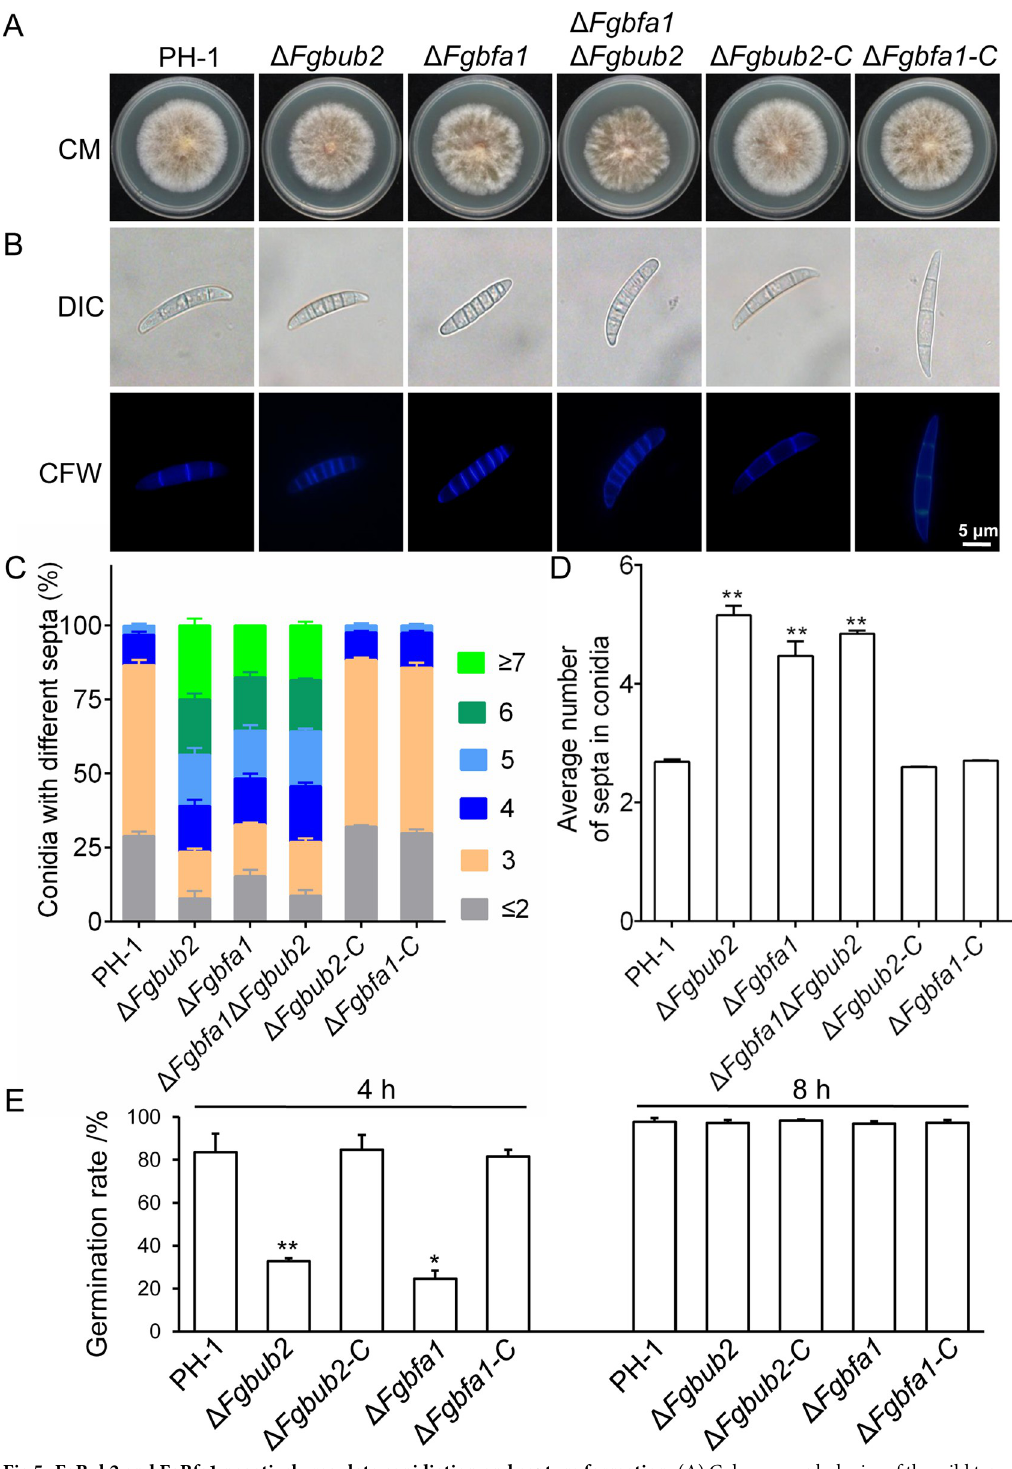
Fig 5. FgBub2 and FgBfa1 negatively regulate conidiation and septum formation. (A) Colony morphologies of the wild type (PH-1), FgBUB2 deletion mutant ( Δ Fgbub2 ), FgBFA1 deletion mutant ( Δ Fgbfa1 ), FgBUB2-FgBFA1 double deletion mutant ( Δ Fgbfa1 Δ Fgbub2 )and the complemented strains ( Δ Fgbub2 -C, Δ Fgbfa1 -C) grown on CM at 28˚C for 3 days. (B) Conidial morphology and number of septa in the PH-1, Δ Fgbub2 , Δ Fgbfa1 , Δ Fgbfa1 Δ Fgbub2 , Δ Fgbub2 -C and Δ Fgbfa1 -C strains after incubation in liquid CMC for 3 days and observed under a fluorescence microscope. Conidia were stained with 10 μ g ml -1 of